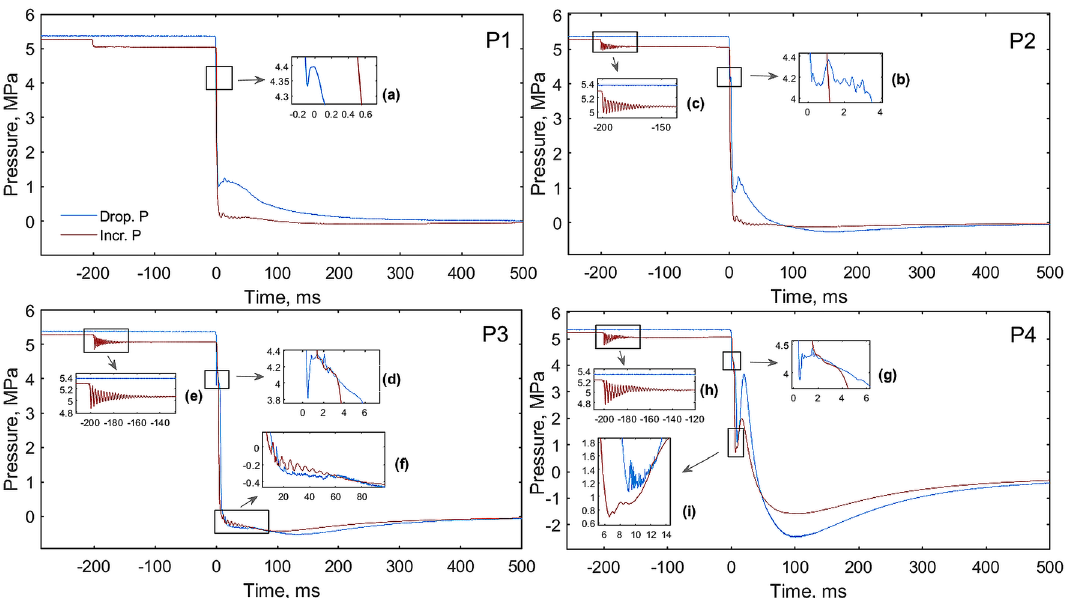
the MPS (Drop. P line). Enlarged segments (c), (e) and (h) show the oscillations due to HP diaphragm rupture, and ( a ), ( b ), ( d ), (f), (g) depres- 2 and (i) show fluctuations due to wave reflection